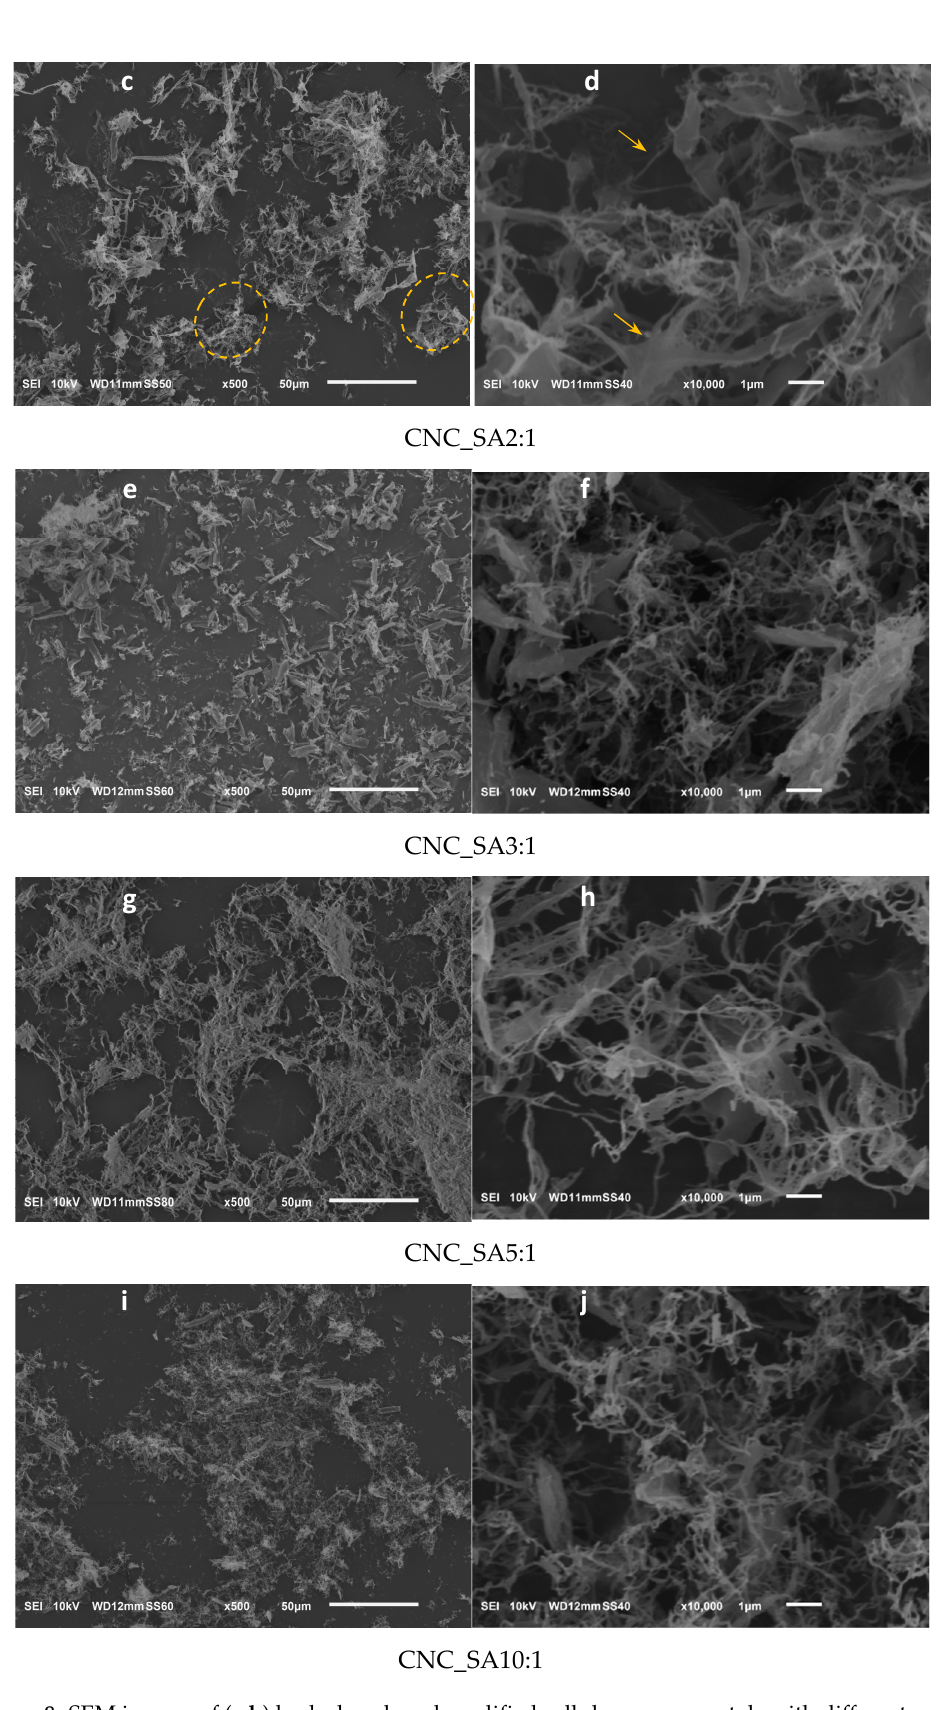
Figure 8. SEM images of ( a , b ) hydrolysed; and modified cellulose nanocrystals with different molar ratios of SA:OH: ( c , d ) CNC_SA2:1; ( e , f ) CNC_SA3:1; ( g , h ) CNC_SA5:1 and ( i , j ) CNC_SA10:1.